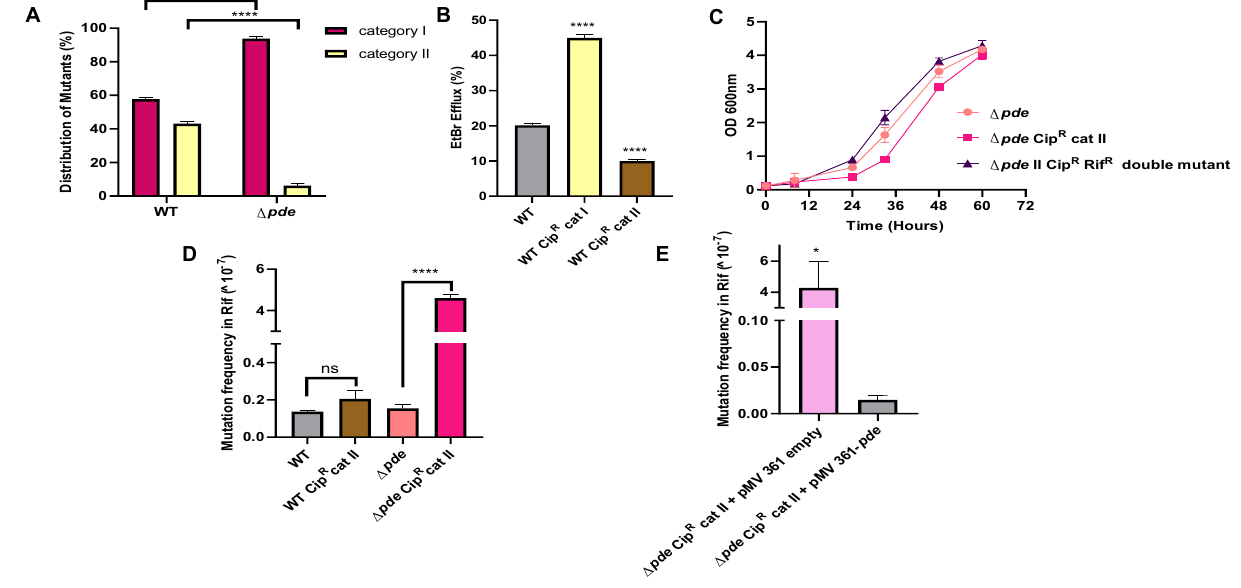
Figure 3. ( A ) Increased c-di-AMP concentration determines the mutational landscape and results in the high probability of non-QRDR (Category-I) mutations in Δpde strain, which are only resistant at to 10X MIC, but do not survive at higher 60X MIC of ciprofloxacin. A two-way ANOVA test was performed to check statistical significance [N = 3]. ( B ) EtBr efflux assay demonstrated a high degree of efflux activity in category I cip R (non- QRDR) mutant, but not in category II cip R (with a QRDR SNP) mutant or parental strains [N = 3]. ( C ) High fitness cost associated with D94N mutation in the GyrA protein subunit was observed in the case of Δpde (cip